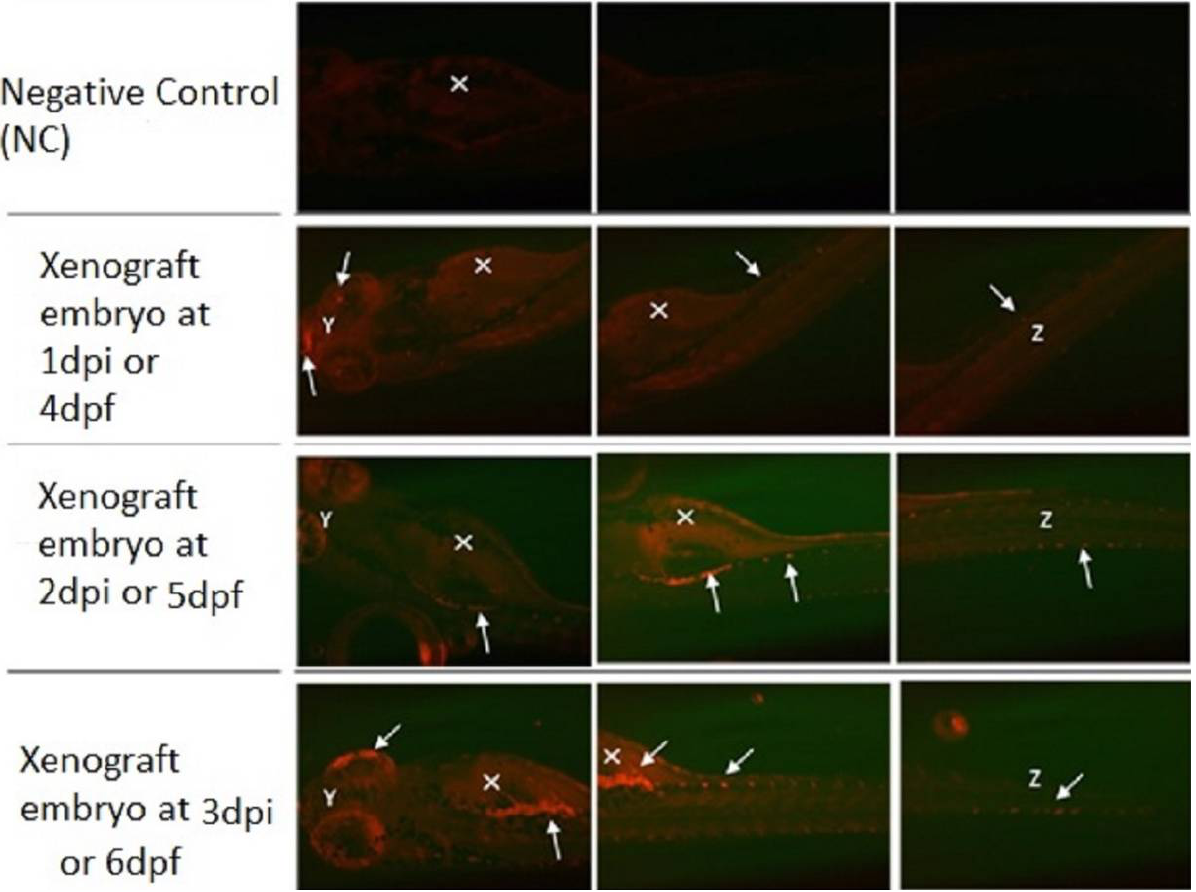
Figure 7. Zebrafish Xenograft model injected at 3 dpf. Representative fluorescence images of zebrafish screening at 4 dpf to 6 dpf using fluorescent microscopy and investigation of fluorescent K562 cells proliferation (white solid arrows) all over the animal body (Y—eyes; X—yolk sac; Z—tail) using mCherry fluorescence filter. Original magnification 100×.